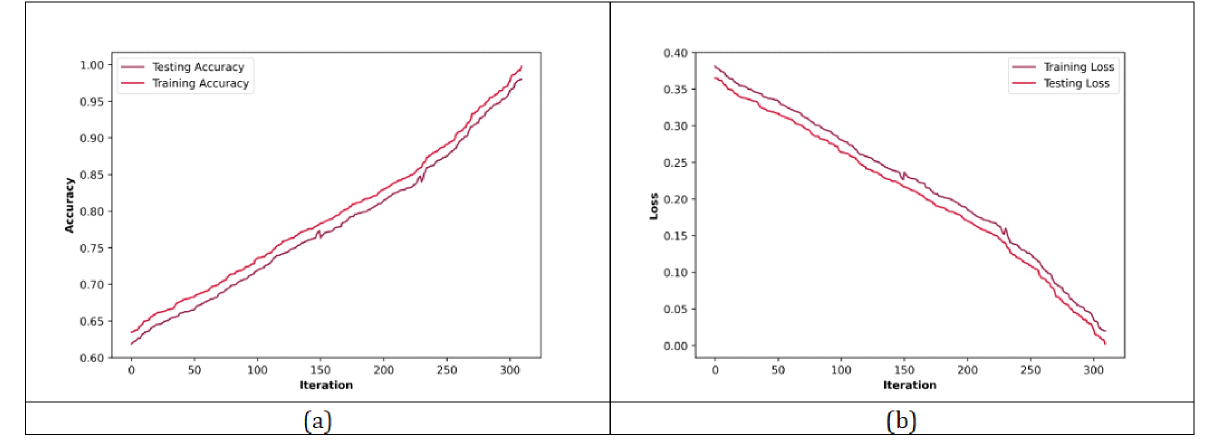
Figure 8. Performance analysis based on ( a ) accuracy and ( b ) loss for Review Rating Prediction using IMDB dataset.